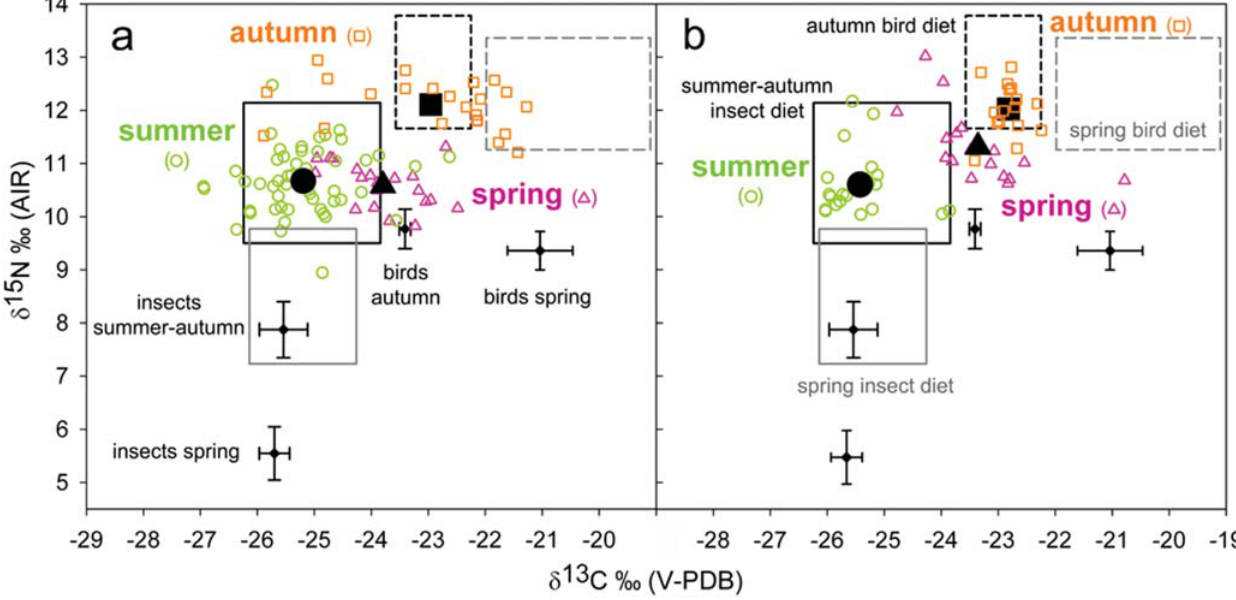
Figure 2. Stable isotope values ( d 13 C and d 15 N) found in bat blood in 2003 (a) and 2004 (b). Individual samples are depicted by small, empty symbols in color, whilst large black symbols show corresponding average group values (seasons are shown with different colours; labelling on both graphs). Mean ( 6 SE) values for potential prey are also shown as small diamonds with bi-directional error bars (labels in 2a). Boxes represent the range of expected values, considering 99% CI for prey and accounting for fractionation factors in the blood of bats that would mirror a pure invertebrate diet (full frames) or a pure bird diet (dashed frames) in spring (grey frames), summer and autumn (black frames, labels in 2b), respectively (see Methods). Partial labelling for prey isotopic signatures («crosses») and expected dietary isotopic signatures (rectangular frames) are shown to enhance clarity.